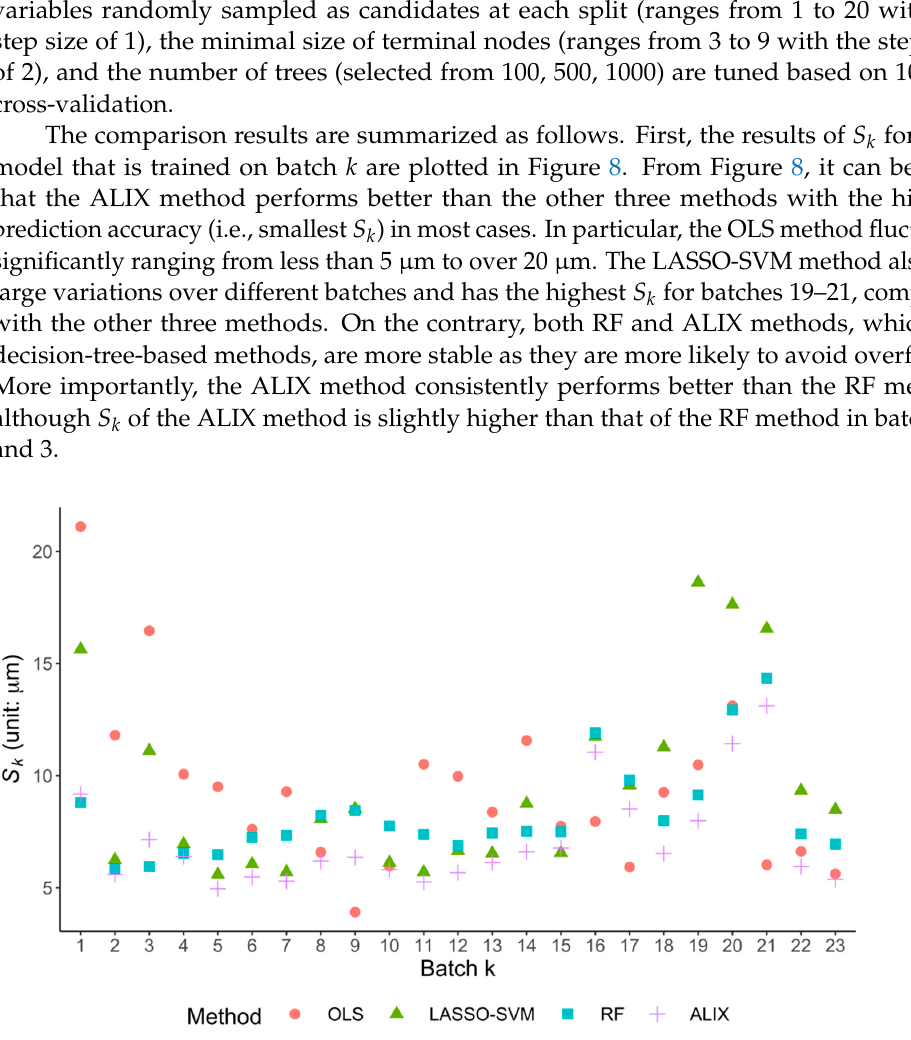
Figure 9. Results of 𝑅 (cid:3038) for each model that is trained on batch 𝑘 . Further, the results of worst-case scenario prediction 𝑊 (cid:3038) for each model that is trained on batch 𝑘 are plotted in Figure 10, from which we can see that the proposed ALIX method has the best performance with the smallest 𝑊 (cid:3038) .